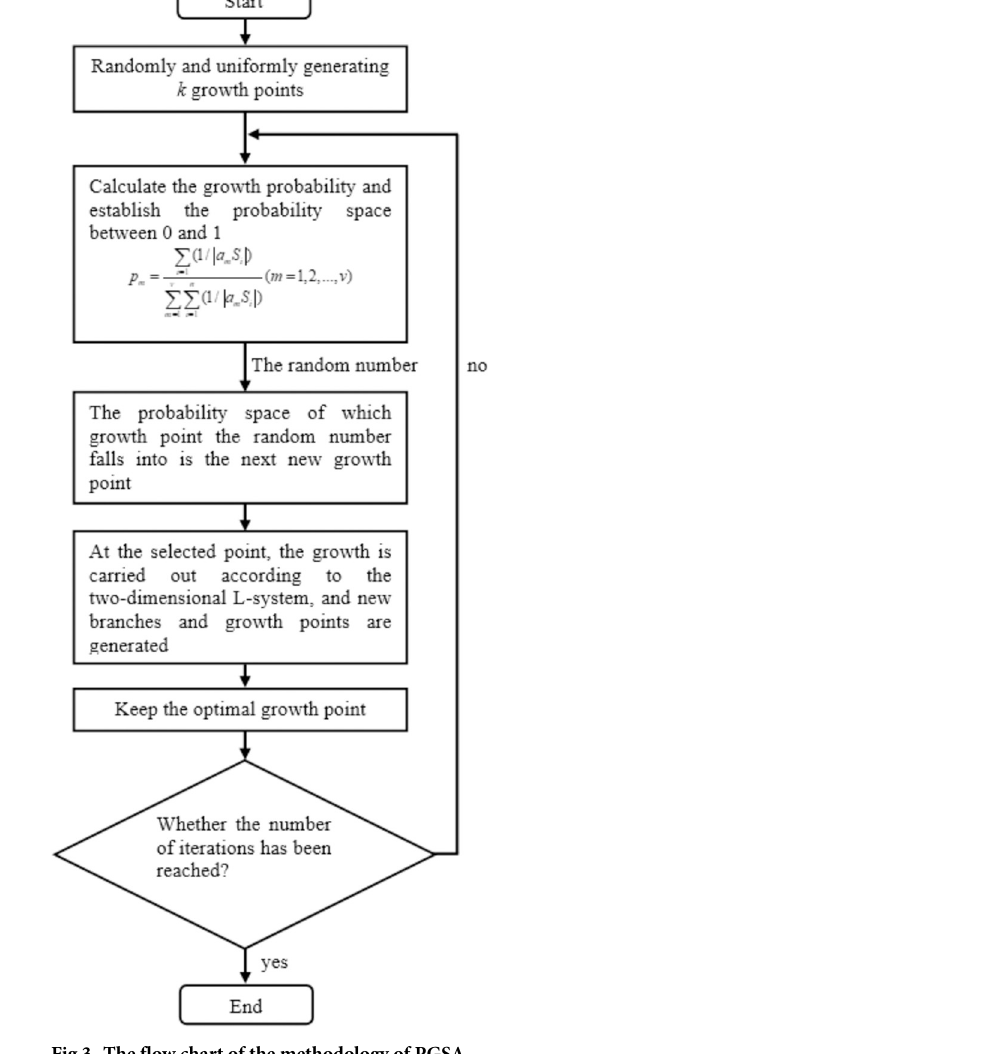
Fig 3. The flow chart of the methodology of